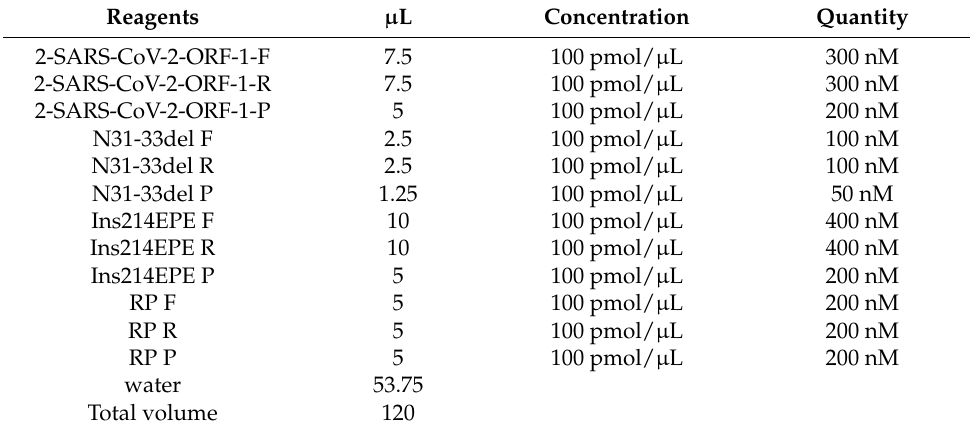
Table 6. Oligonucleotides’ premixing protocol for 100 reactions.